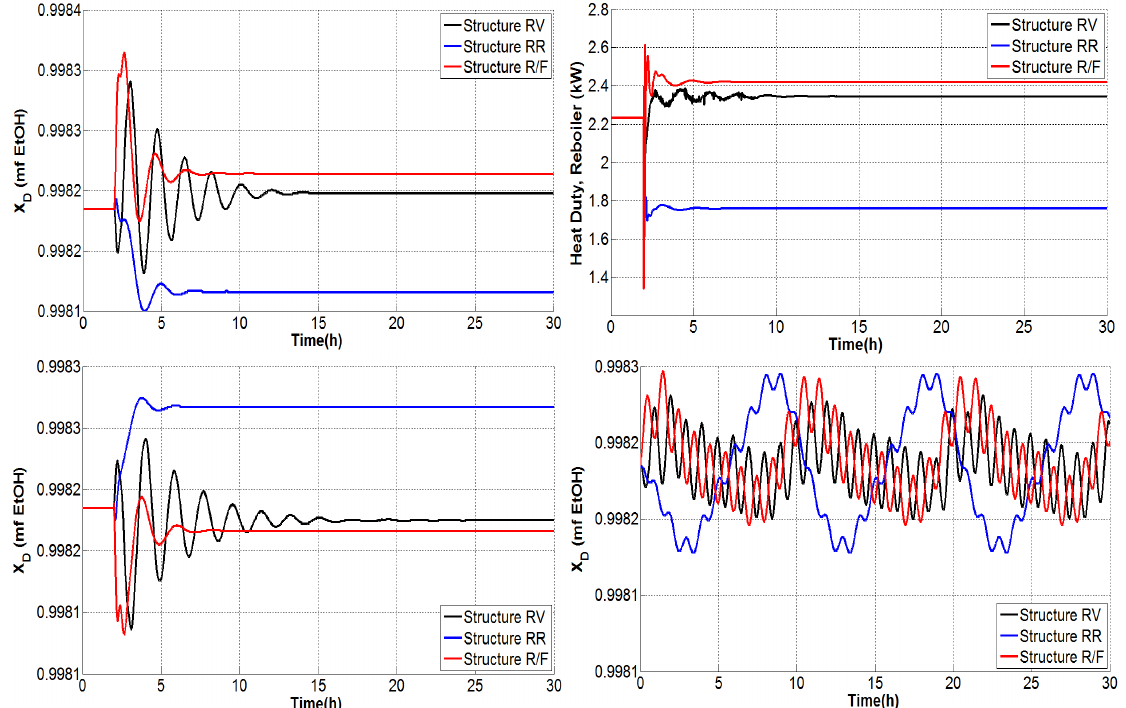
Figure 16. Performance of the structures and reboiler energy consumption under step perturbations of the feed flux rate with amplitude of 8% and − 8% with respect to the nominal value, and a continuous fluctuating perturbation.